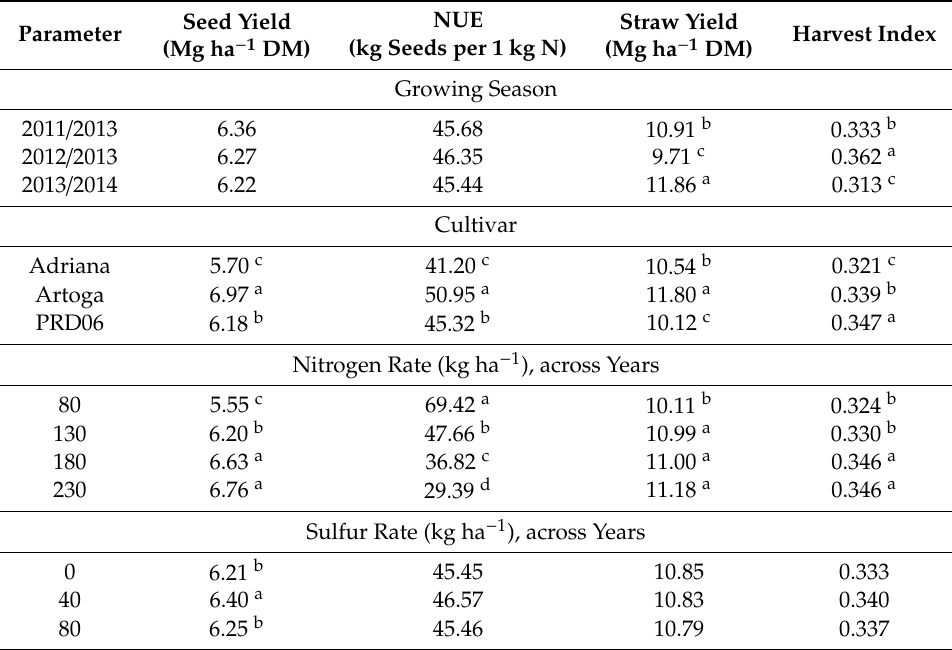
Table 5. Productivity of winter oilseed rape